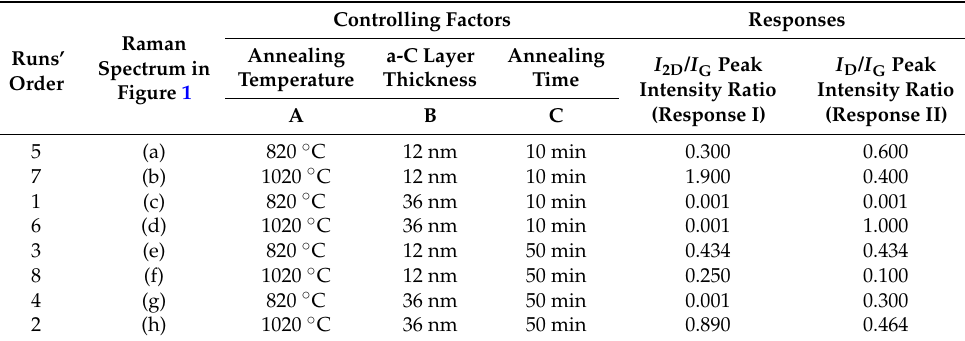
Table 2. Full-factorial DoE analysis.